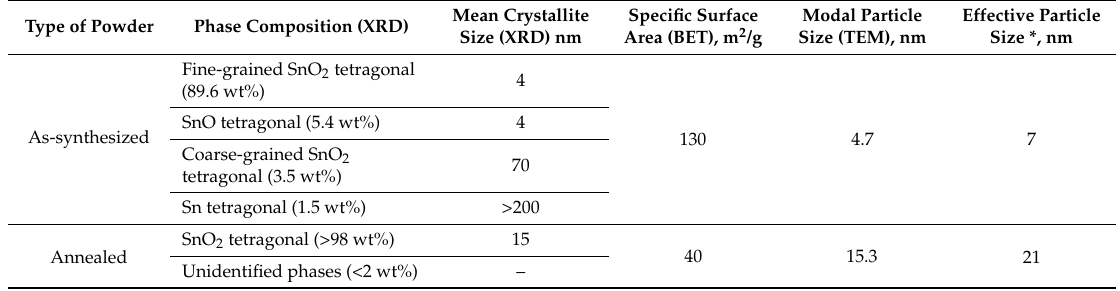
Table A1. Results of characterization of as-synthesized and annealed